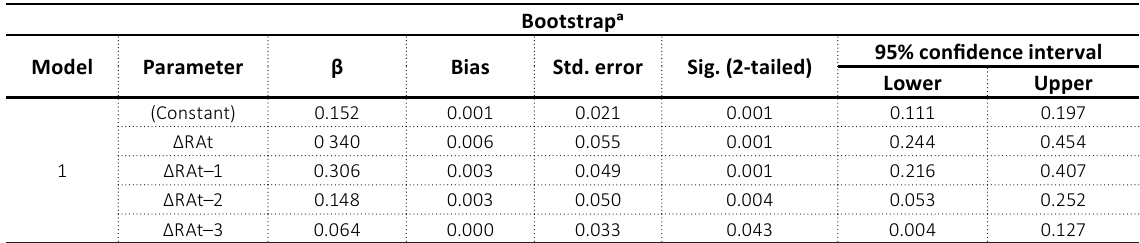
Table 8. CEO and Director total pay to market